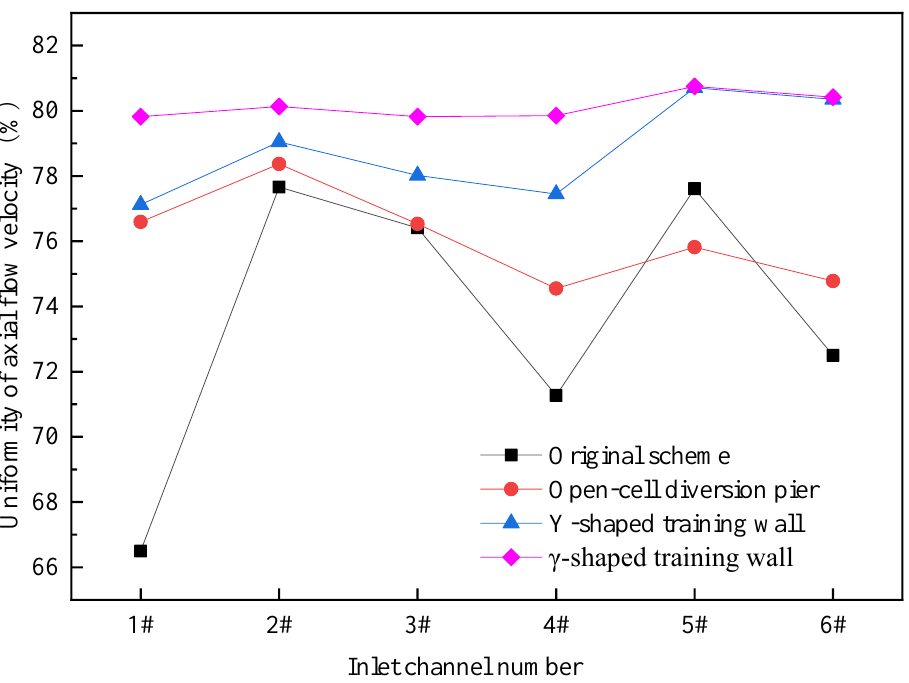
Figure 17. Comparison of rectification effects of various schemes (operational state of pumping). When the sluice was operating, after setting the γ -shaped settlement training wall, the flow line in front of the sluice was relatively smooth and the original reflux area basically disappeared. Considering the navigation requirements of the sluice, we took the maximum transverse velocity in front of the 7# sluice as the research index and then performed the horizontal comparison of the rectification effects between the γ -shaped settlement training wall and three other measures: the initial scheme, which was not designed with any rectification measure, the perforated training wall scheme in document [32], and the Y-shaped settlement training wall in document [17]. As displayed in Figure 18, when the γ -shaped settlement training wall applied, the maximum lateral velocity in front of the 7# sluice was 0.28 m/s, which was less than the limit value of 0.3 m/s regulated in reference [34], satisfying the requirements of modern navigation. Compared with the initial scheme, the maximum transverse velocity was abated by 0.47 m/s, which shows the γ -shaped settlement training wall can effectually ameliorate the flow state ahead of the sluice of the joint hub of pump station and sluice. Meanwhile, compared with the Y-shaped settlement training wall scheme in document [17], its maximum lateral velocity in front of the 7# sluice was still 0.28 m/s, indicating that there was no significant difference between the two forms of the training wall on the variation of transverse velocity in front of the sluice next to the junction of the sluice and the pump station. While in comparison with the scheme of perforated the training wall in the literature [32], its maximum trans- verse velocity in front of the 7# sluice was 0.06 m/s lower than that of the γ -shaped settle- ment training wall, indicating that under the free-draining condition, the perforated train- ing wall was the most effective one to abate the transverse velocity in front of the sluice next to the junction of the pump station and sluice chamber and alleviate the oblique inlet flow. Additionally, considering the actual operation conditions of project, the average transverse velocity in front of the sluice chamber was taken as an extra research indicator and by a series of calculations, the index values of each scheme were as follows: the initial scheme: 0.74 m/s, the scheme of Y-shaped settlement training wall: 0.28 m/s, the scheme of γ -shaped settlement training wall: 0.26 m/s, and the scheme of perforated training wall: 0.24 m/s. It can be found that compared with the initial scheme and the Y-shaped settle- ment training wall, the γ -shaped settlement training wall was more applicable and can